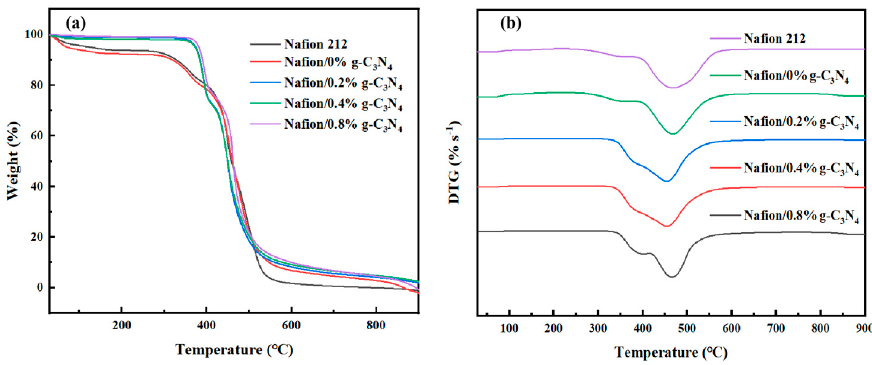
Figure 7. ( a ) TGA and ( b ) DTG diagrams of Nafion/g − C 3 N 4 modified